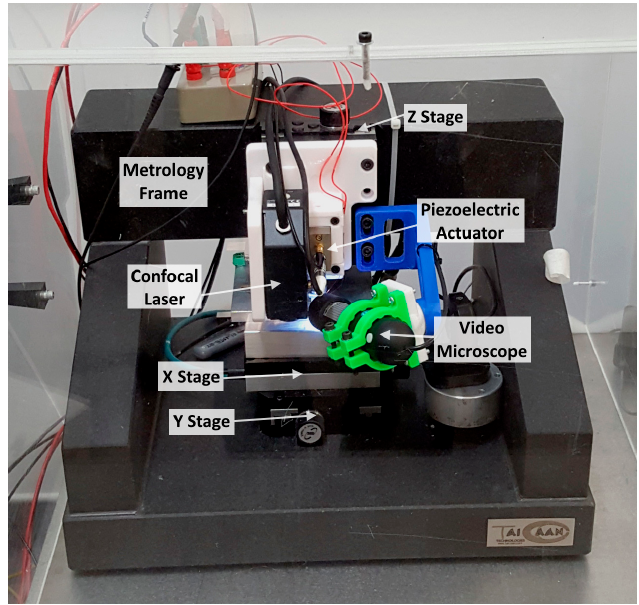
Figure 1. The In-situ Contact Evolution (ICE) apparatus, based on a XYRIS 4000CL, TaiCaan Technologies, Southampton, UK. The lower contact is carried on the XY motion system, while the upper contact is carried on the lower tip (obscured by video microscope) of the piezoelectric actuator. During switching (Figure 2a), the actuator (BPC301, ThorLabs, Newton, NJ, USA) moves the upper contact to open and close the contact. The actuator is capable of high speed cyclic operation (>1.25 kHz). In this study the switching cycling is interrupted after each switching operation to allow contact surface measurement.